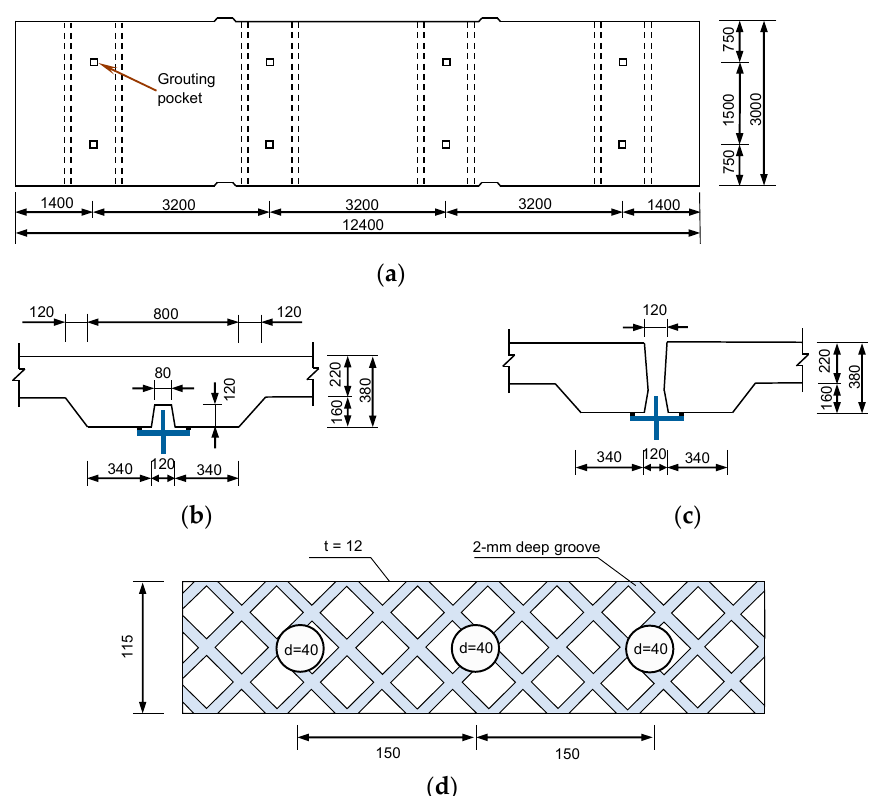
Figure 23. Details of the UHPC grout strip shear connection (dimensions in mm): ( a ) plane view of precast deck panel; ( b ) details of grouting channel; ( c ) details of grouting pocket; ( d ) details of embossed steel plate.